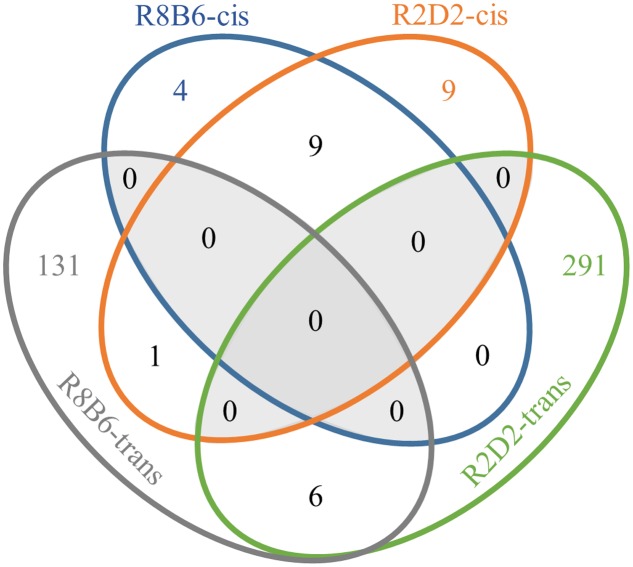
Venn diagram illustrating correspondence of R8 vs. B6 differentially expressed genes and R2 vs. D2 differentially expressed genes.